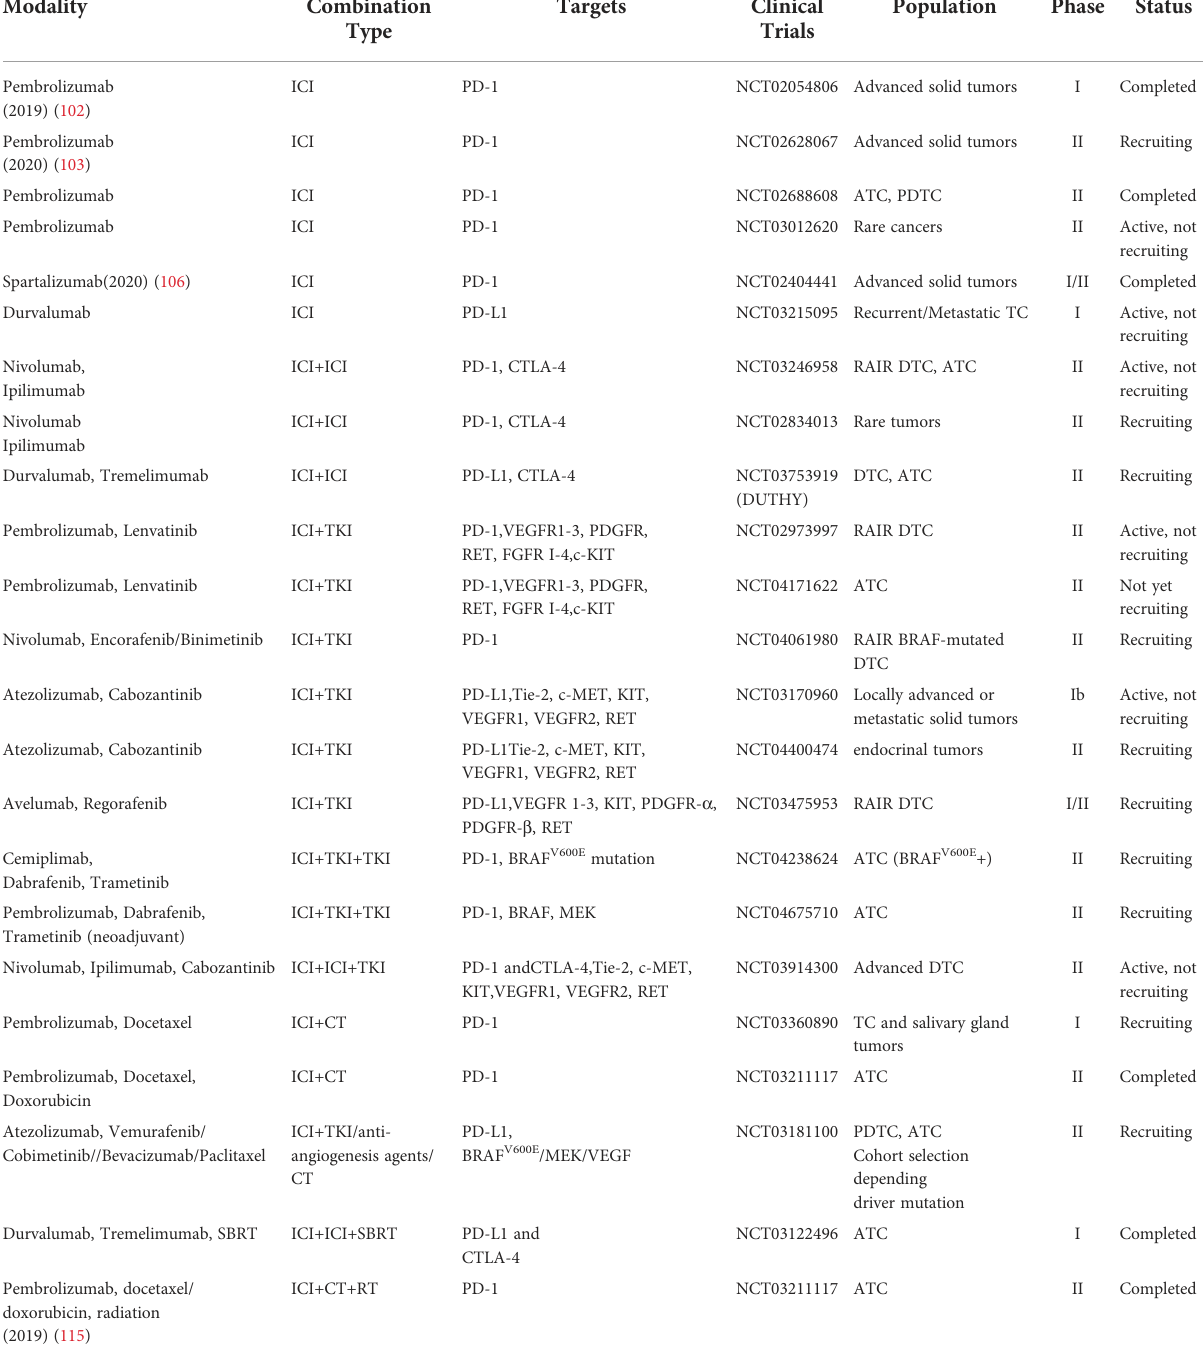
TABLE 4 Clinical trials of ICIs for RAIR-DTC and